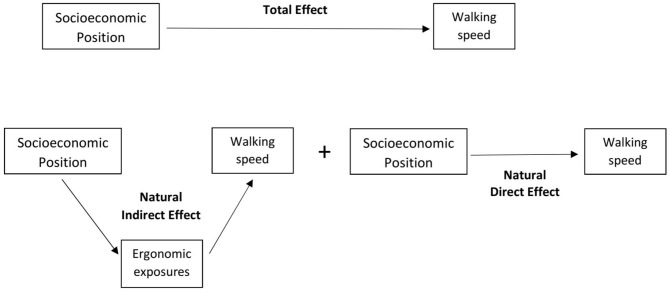
Components of the mediation analysis. Total Effect of socioeconomic position (SEP) on walking speed, decomposed in Natural Direct Effect and Natural Indirect Effect of SEP, the latter mediated by exposure to ergonomic factors at work.